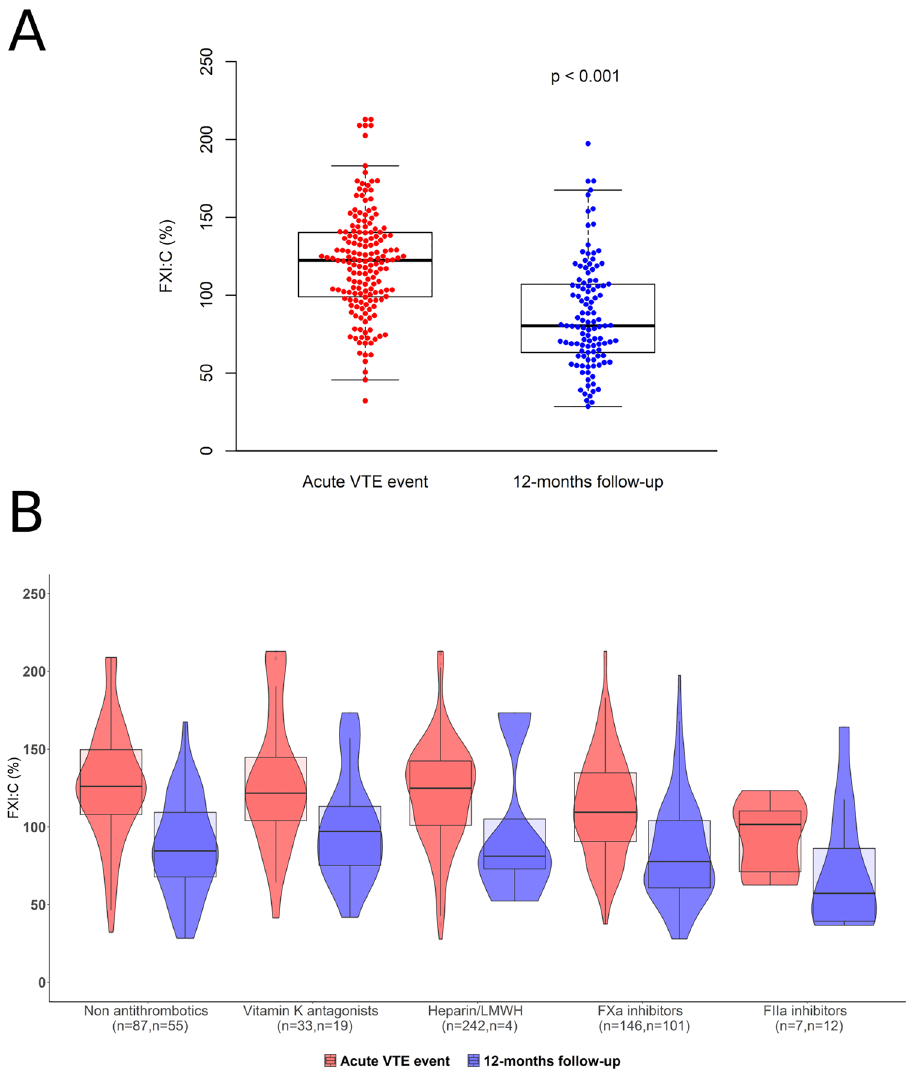
of FXI:C values available at acute VTE event and 12 months follow-up ( n = 187). The p-value was derived from a paired t-test. Panel B shows time differences stratified by type of anticoagulant drug, in red for the acute VTE event and in blue for the 12 month follow up time